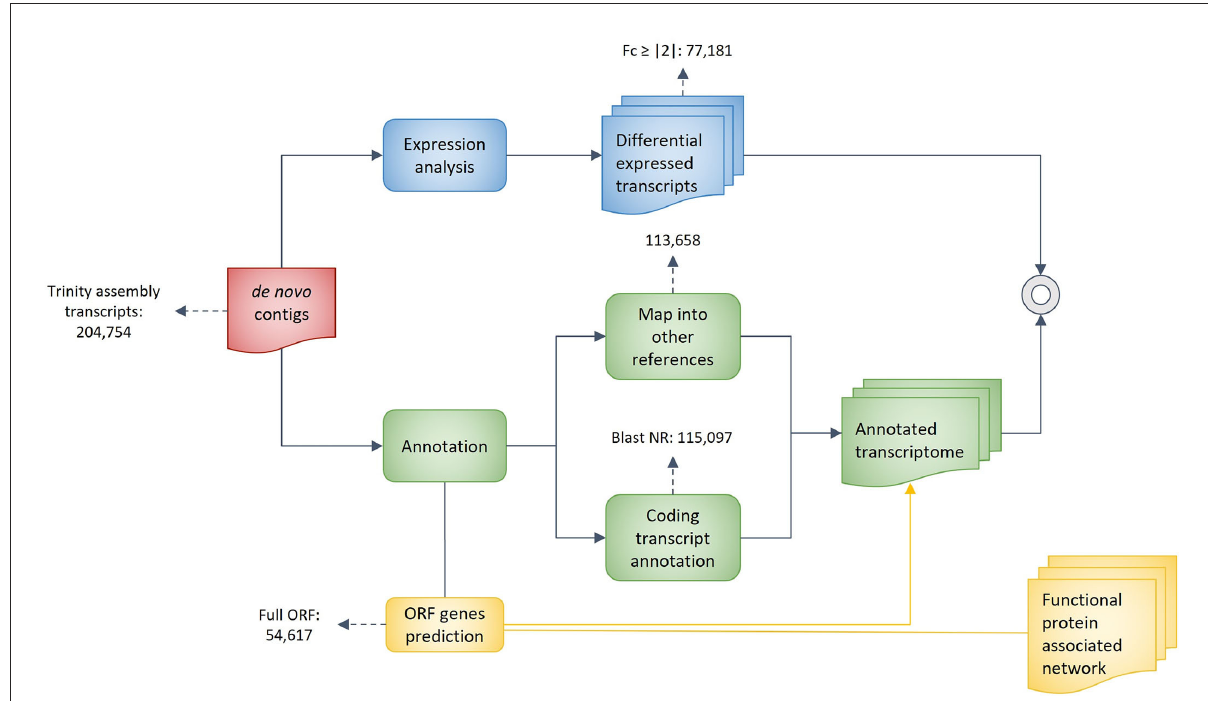
FIGURE1 Flow diagram of gene annotation using transcriptomic reference genome. de novo assembled contigs were annotated using four reference genomes and NR database. Full ORF predicted genes from annotation stage were used for functional protein associated network.